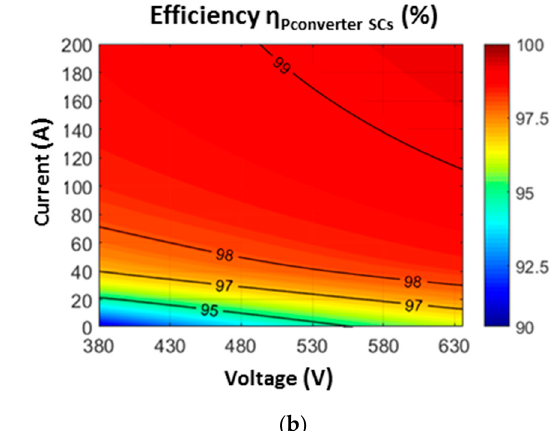
Figure 8. ( a ) Power losses map in the DC/DC converter as a function of the current and voltage in the SCESS module and ( b ) efficiency map in the DC/DC converter as a function of the current and voltage in the SCESS module.